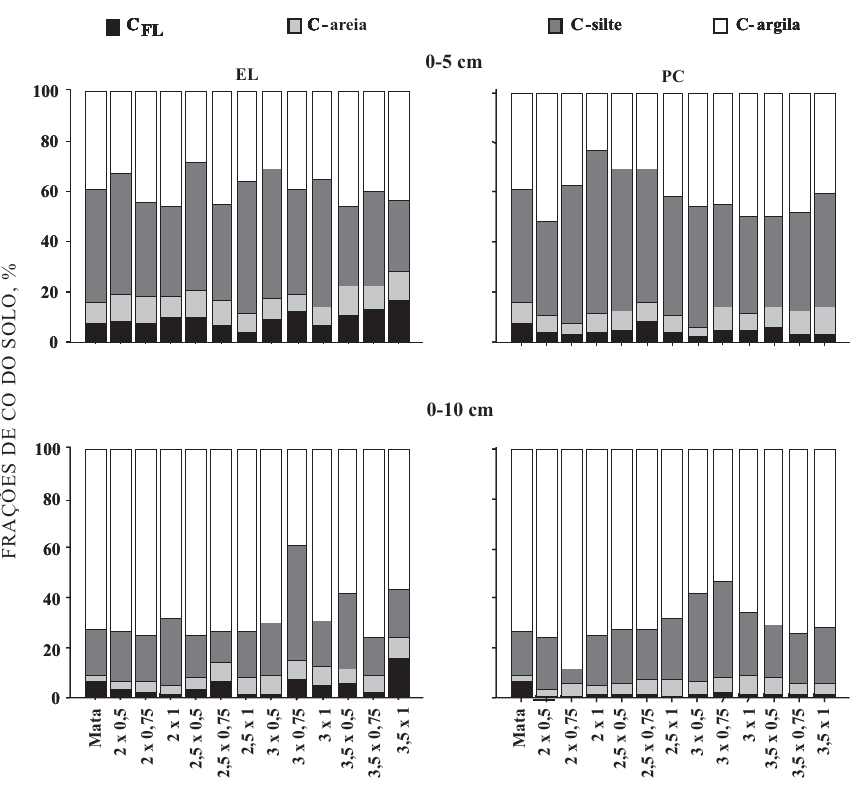
Figura 3. Percentagem do carbono orgânico nas frações leve (C matéria orgânica, nas profundidades de 0–5 e 0–10 cm de um Latossolo Vermelho distroférrico típico cultivado com cafeeiro em diferentes espaçamentos de plantio. EL: amostras coletadas na entrelinha; PC: amostras coletadas na projeção da